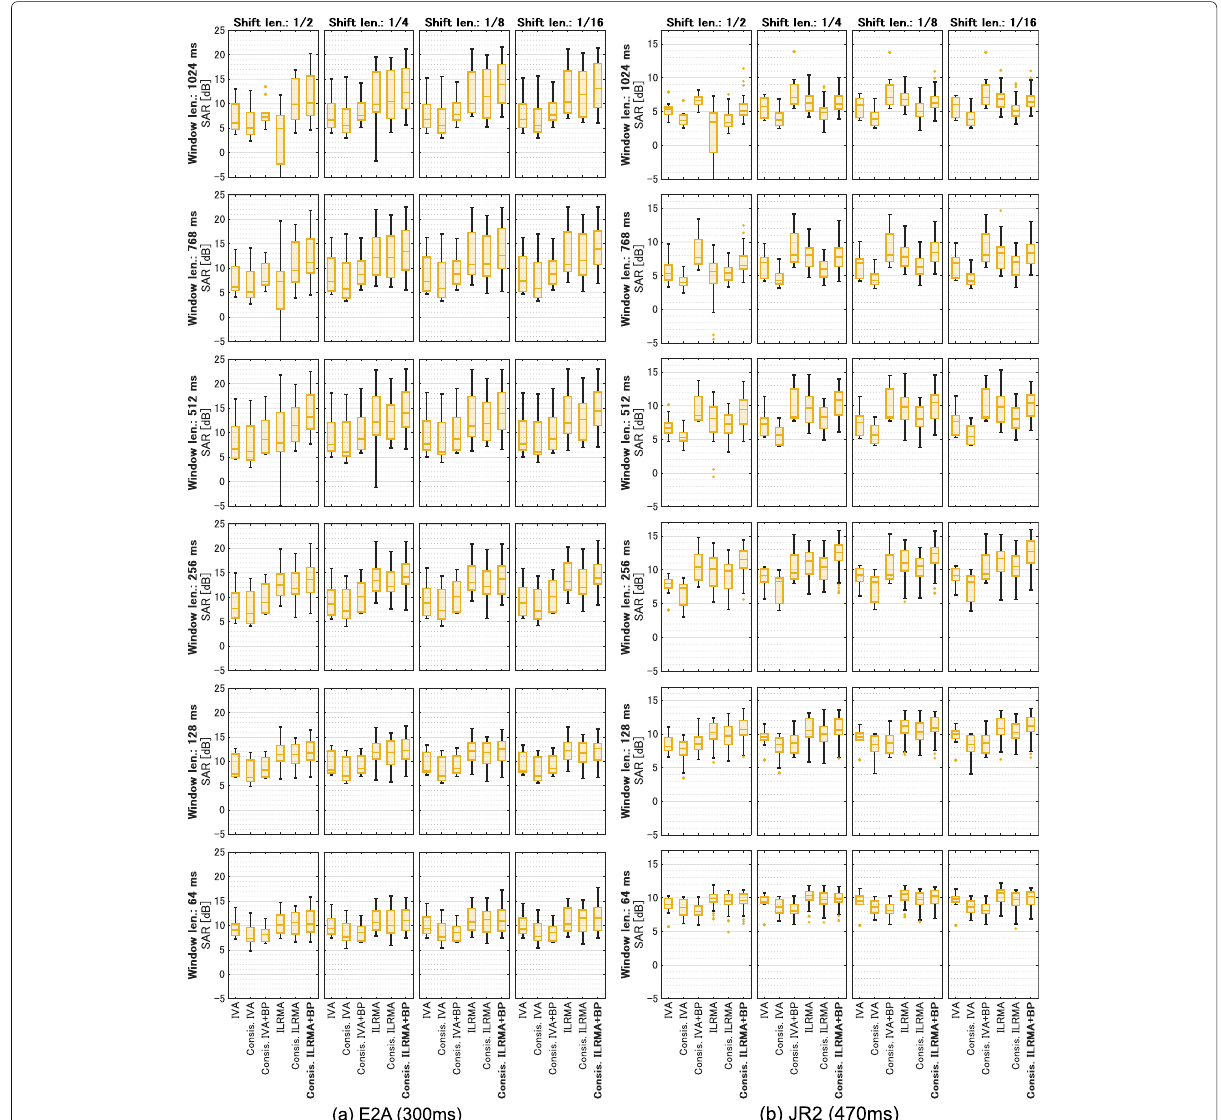
Fig. 23 Average SAR for synthesized music mixtures (music 1–10) with a E2A and b JR2 , where Hamming window is used in